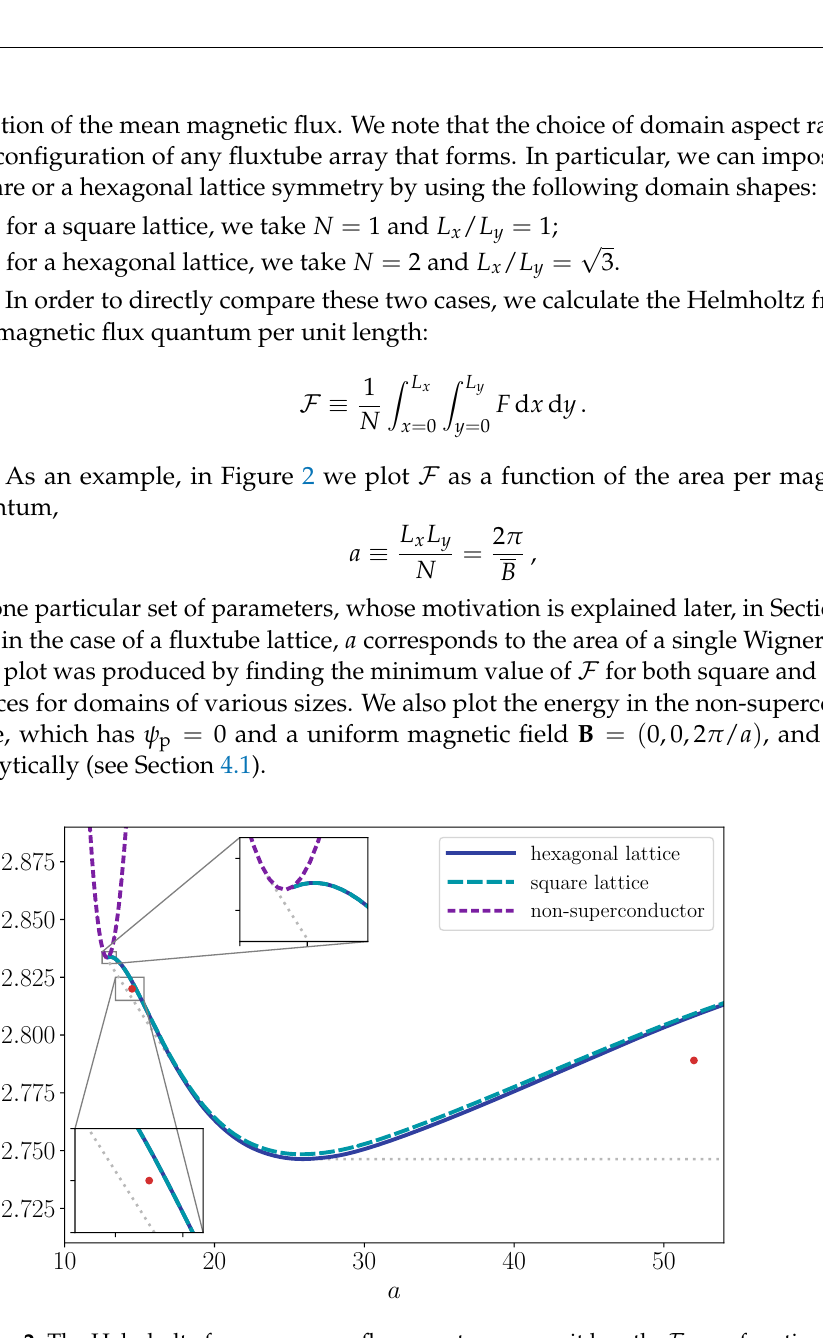
Figure 2. The Helmholtz free energy per flux quantum per unit length, , as a function of the area F per magnetic flux quantum, a , with the dimensionless parameters κ = 1.444, R = 0.371, (cid:101) = 0.097, α = 0, h 1 = 0.102, h 2 = 0.387, and h 3 = 0.263. The energy in both the square (long-dashed, cyan) and hexagonal (solid, blue) lattice states matches smoothly onto the energy of the non-superconducting state (short-dashed, purple) at a 12.9 (region enlarged in the upper inset), and both converge to (cid:39) ∞ . The dotted gray lines indicate the lower convex envelope, plotted the same finite value as a → separately in Figure 3, which is the true ground state in an unbounded domain. The two red dots indicate the values for the two simulations in Figure 4. We show an enlarged view of the left point in the lower